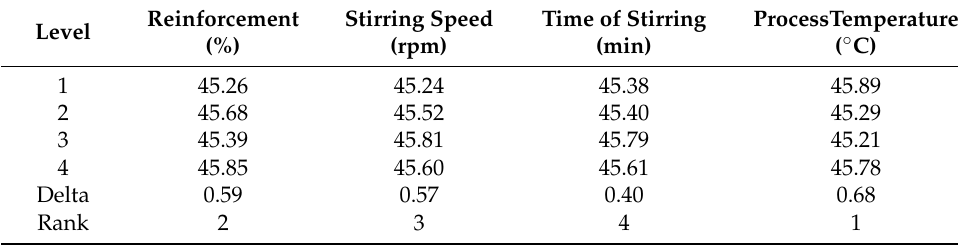
Table 12. Response table for signal to noise ratios (micro